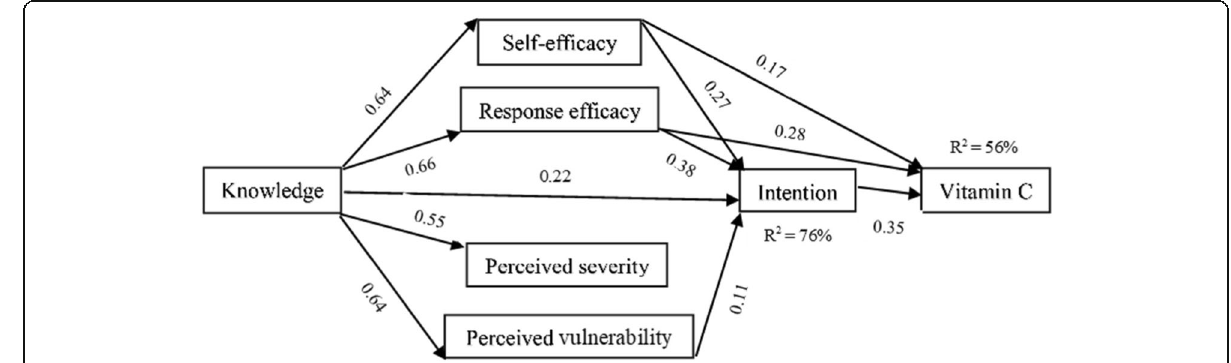
Fig. 2 PMT path model showing the significant standardized beta coefficients of vitamin C behavior